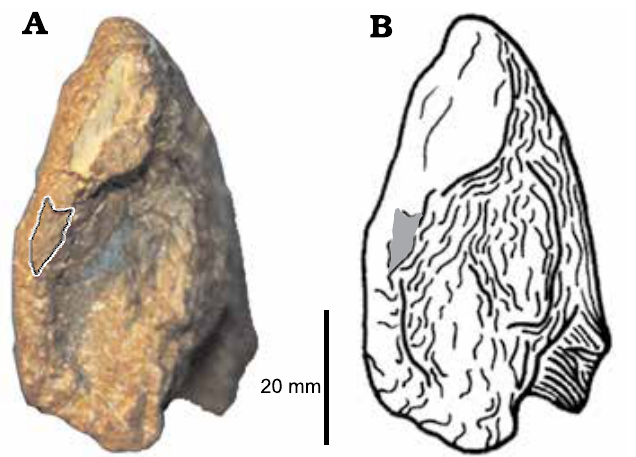
Fig. 4. Photo ( A ) and drawing ( B ) of the right pedal ungual II of the cama- rasaurid sauropod SMA 0002 (Upper Jurassic Morrison Formation, Howe- Stephens Quarry, Wyoming, USA) in proximal view, showing the broken surface indicating overgrowth attachment. Modified from Tschopp et al.